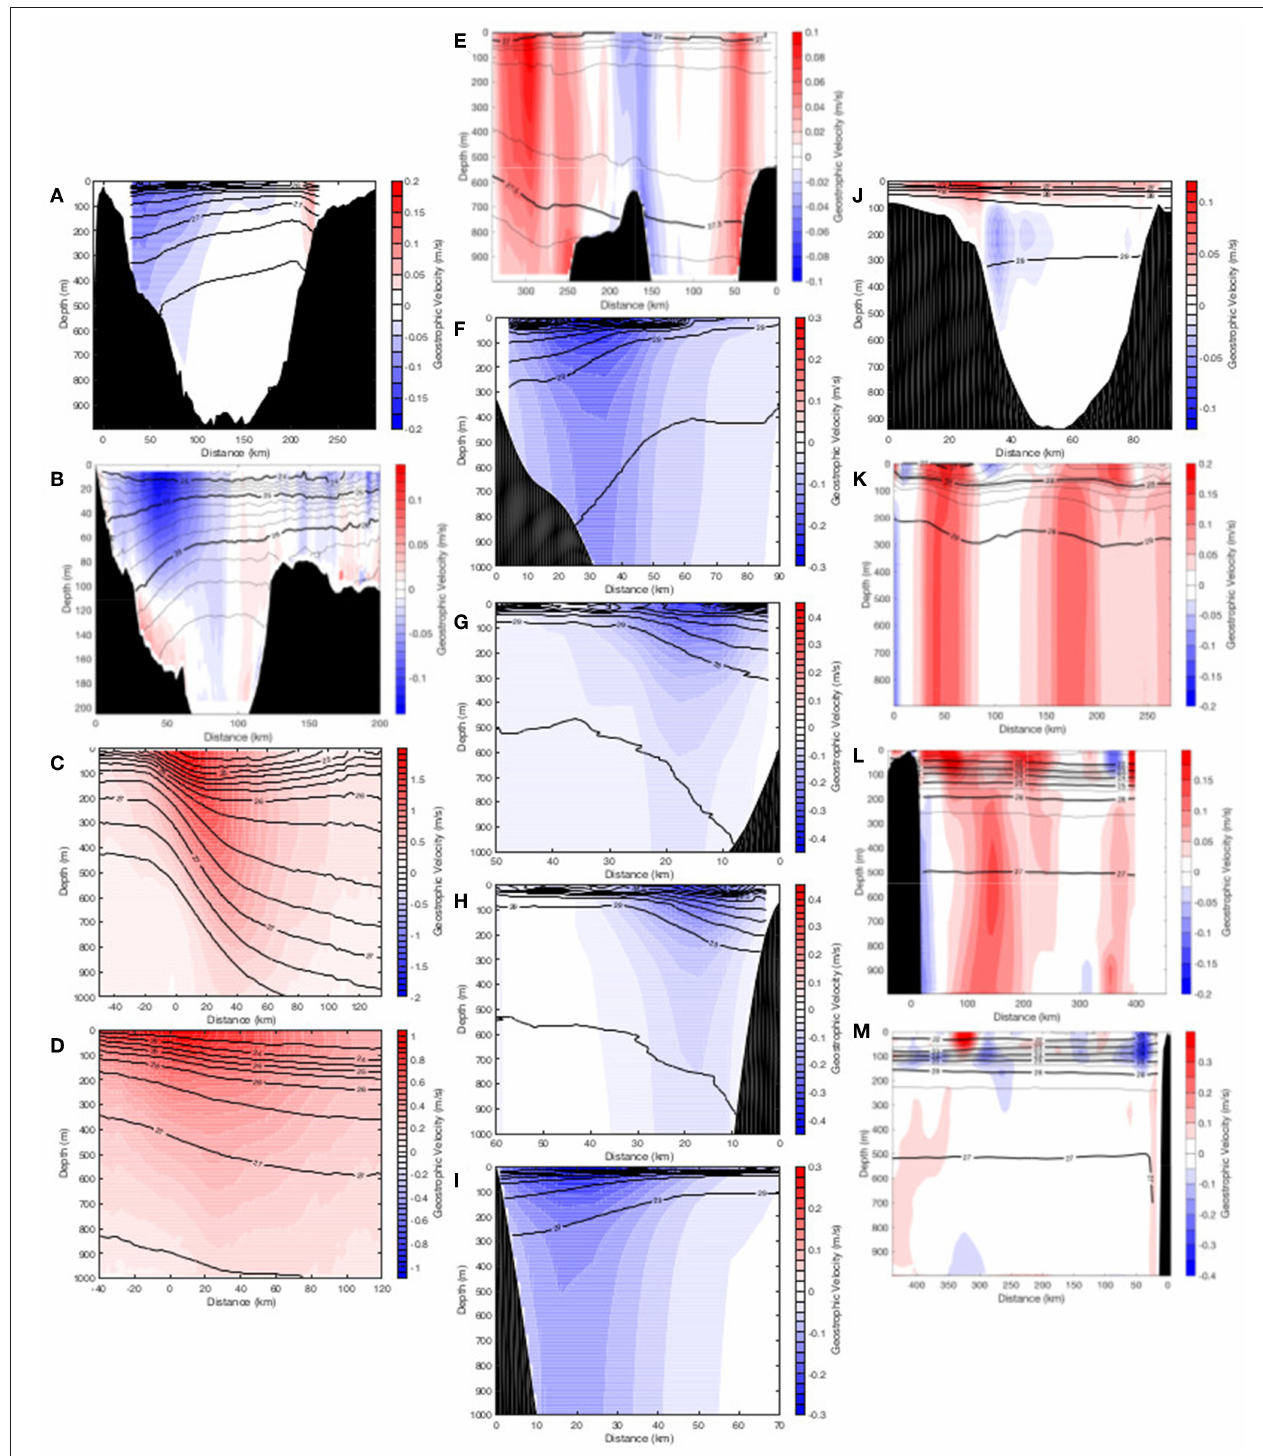
FIGURE 5 | Mean sections of geostrophic velocity from the Atlantic, Mediterranean and Indian Ocean. Sections in the Atlantic include (A) the Davis Strait, (B) the Nova Scotia Current off the east coast of Canada, (C) the Gulf Stream off the eastern US coast, (D) the Gulf of Mexico Loop Current, and (E) the North Atlantic Current west of the UK. Sections in the Northern Current System of the Mediterranean Sea are (F–I) along the southern coast of France, (J) between the Spanish coast and the island of Ibiza, and (K) between Sardinia Island and Menorca. In the Indian Ocean, sections are off the (L) east and (M) south coast of Sri Lanka. The sections are oriented generally west to east or south to north, and positive geostrophic velocity is primarily northward or eastward.